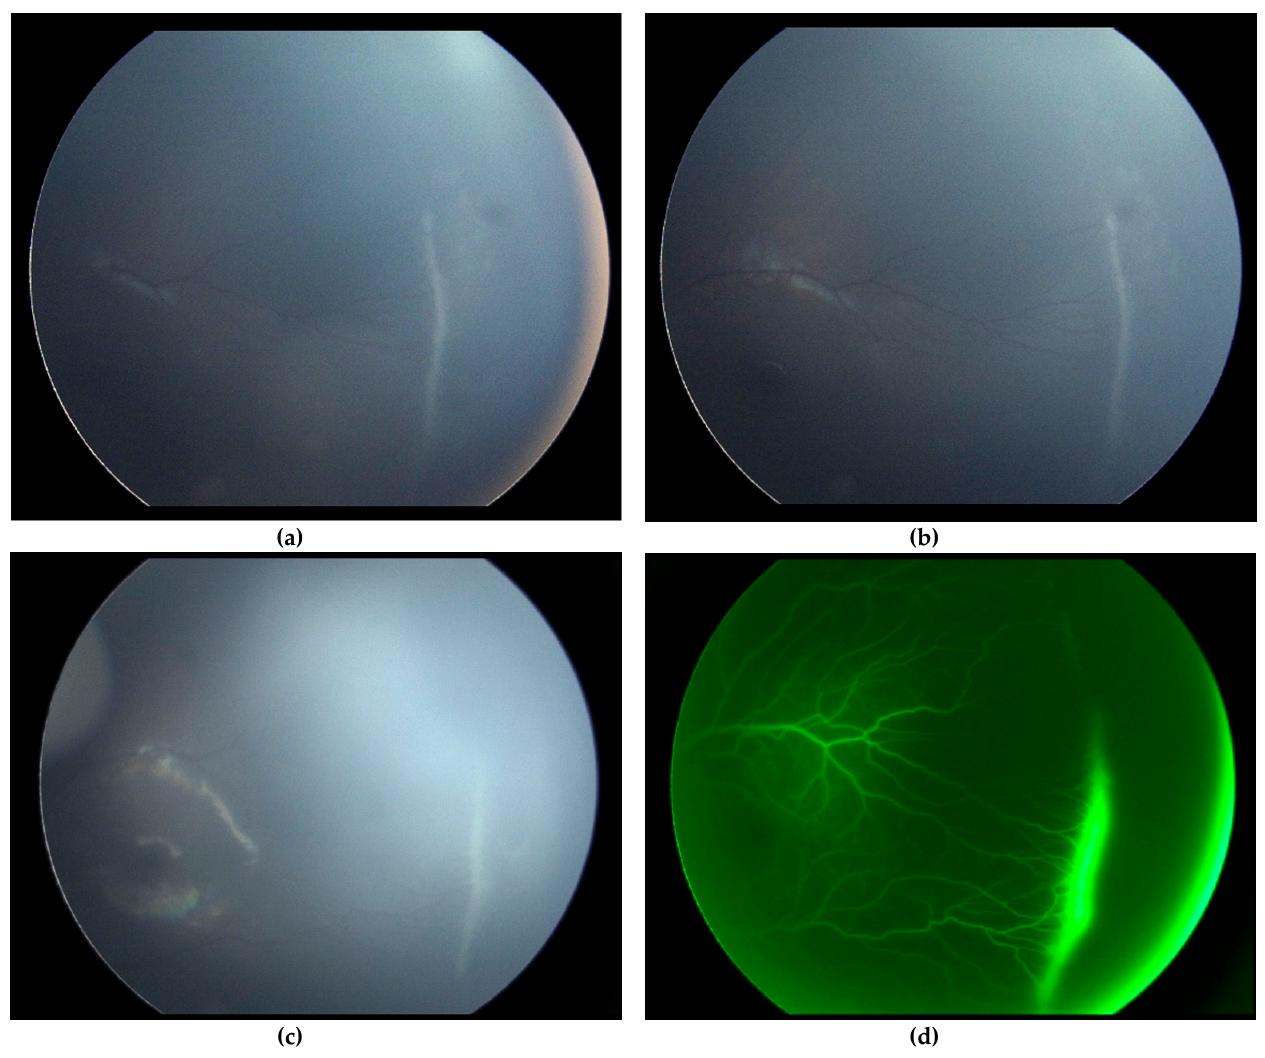
Figure 2. Example of “non-resolved” ROP at 40 weeks of amenorrhea-corrected age. Both upper retinography images ( a , b ) show “non-resolved” ROP at 40 weeks of amenorrhea-corrected age. We can visualize the ridge and the avascular retina beyond it. The limit of vascularization is located at posterior zone II. The ICROP3 stage of this eye is stage 3 posterior zone II, without plus or pre-plus disease. Both lower images ( c , d ) show the same eye two weeks later. We can see in this